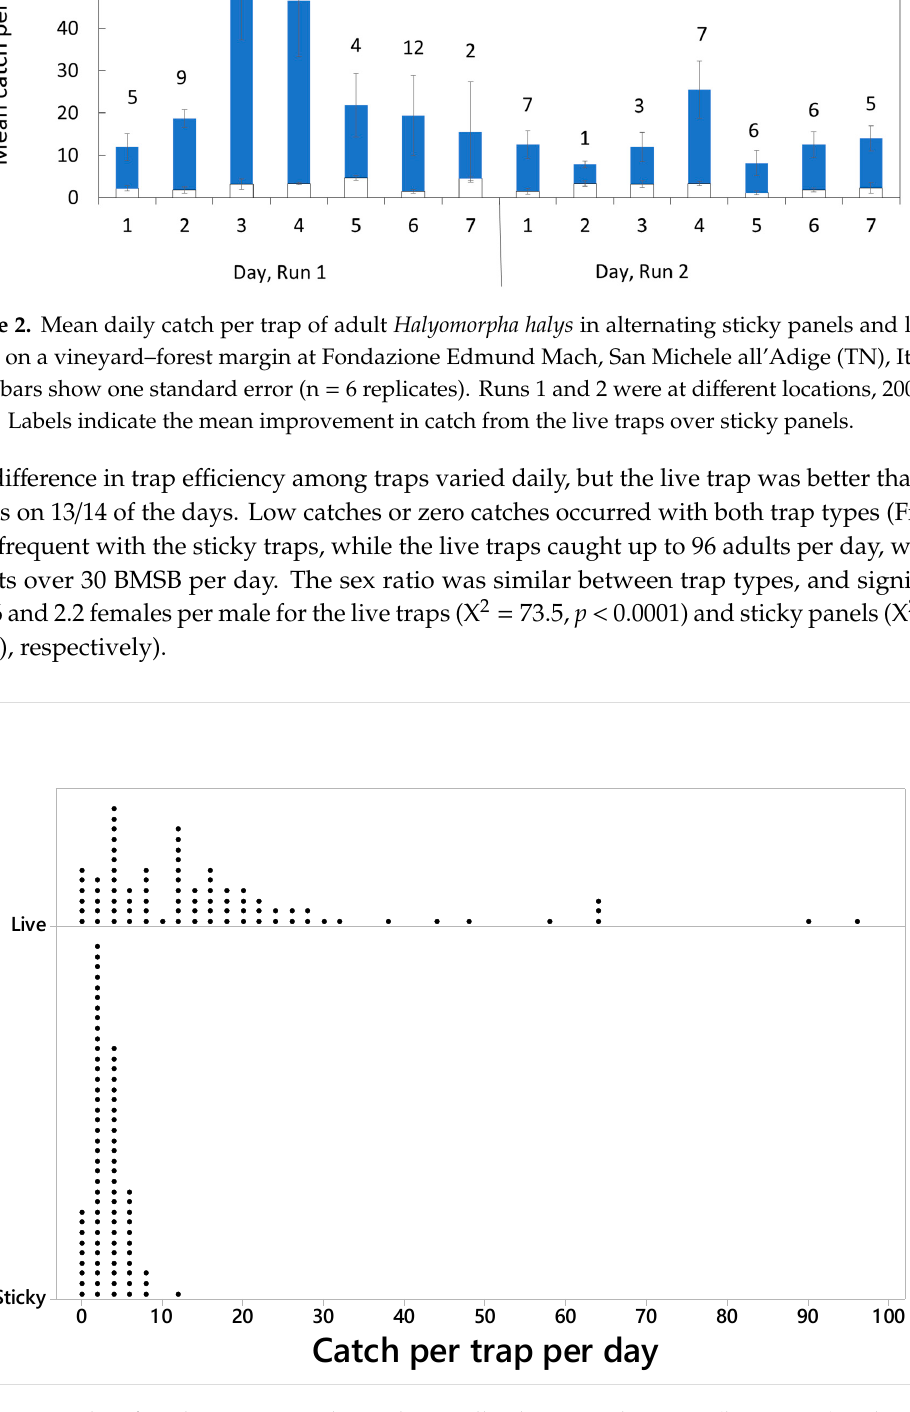
Figure 4. Effect of transect positions on mean daily catch of Halyomorpha halys by sex and trap type at the forest–vineyard margin in San Michele all’Adige (TN), Italy (n = 6 replicates, operated for 14 days (runs combined)). 4. Discussion Effective pest monitoring is an essential tool for IPM, and pheromones have provided a tremendous boost to this field by attracting insects directly to traps. Efficient traps can support management decisions, to restrict the use of insecticides and reduce costs, non-target effects, and secondary pest outbreaks. The need for understanding the meaning of a stink bug in a trap in IPM